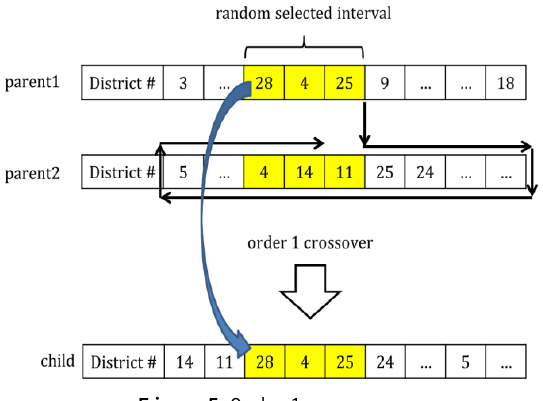
Figure 5. Order-1 crossover.